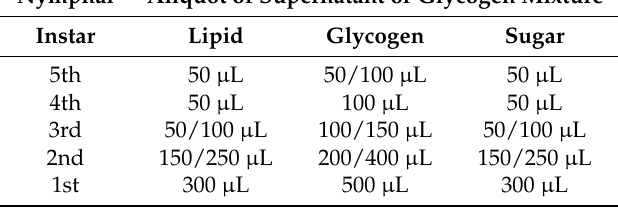
Table 1. Aliquot taken from the supernatant for lipid and sugar reading and aliquot taken from the first glycogen-anthrone mixture for glycogen readings based on the nymphal instar of brown marmorated stink bug (BMSB) nymph.